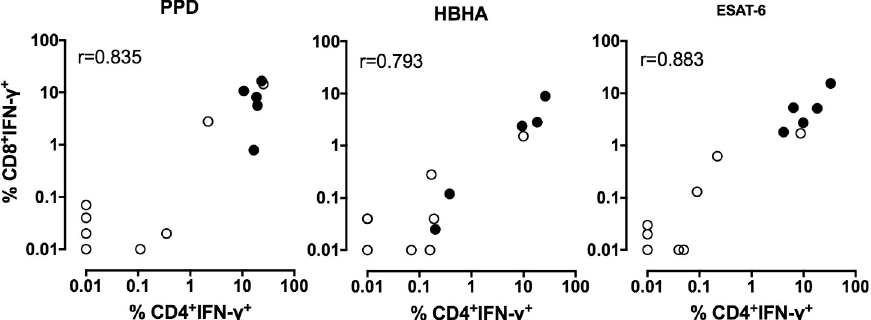
Fig 3. Correlations between the percentages of IFN- γ -containing CD4 + and CD8 + T lymphocytes induced by the mycobacterial antigens. Ascites lymphocytes were in vitro cultured overnight in the absence (medium) or the presence of PPD, HBHA or ESAT-6, and the percentages of IFN- γ -containing CD4 + and CD8 + T lymphocytes were analyzed by flow cytometry. The values shown are obtained by subtracting the values obtained in the absence of antigen stimulation from those obtained in response to mycobacterial antigens. Filled circles represent values from patients suffering from TB, whereas open circles represent values from non-TB patients. r: Spearman coefficient of